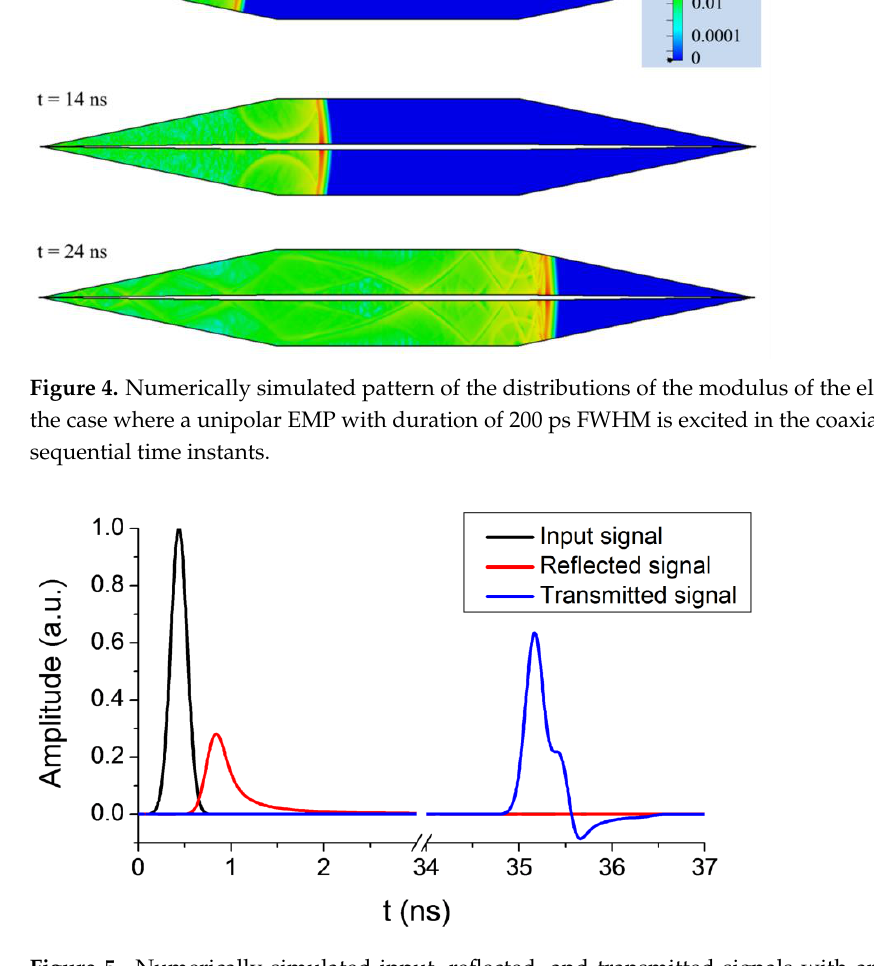
Figure 5. Numerically simulated input, reflected, and transmitted signals with an EMP with a duration of 200 ps FWHM.